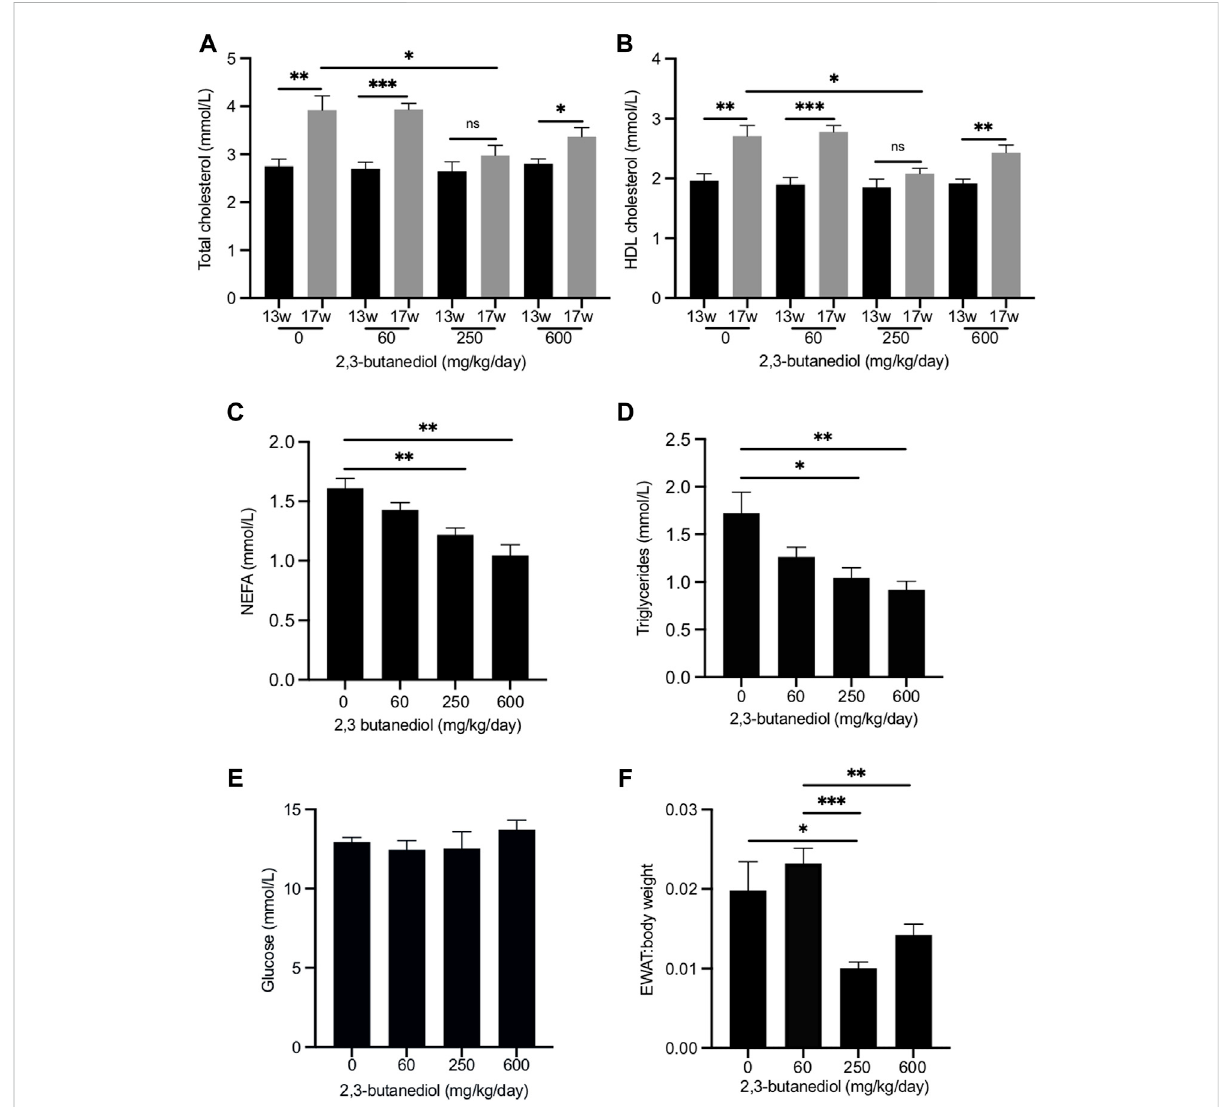
FIGURE 3 Dose-dependentin fl uenceof2,3-butanedioltreatmentonplasma metabolite concentrationsand fatdeposition. (A) Total cholesterol. (B) HDL cholesterol. (C) NEFA. (D) Triglycerides. (E) Glucose (F) EWAT:body weight ratio. Male mice were either untreated (0 mg/kg/day) or treated with 2,3- butanediol at either 60, 250 or 600 mg/kg/day, for 4 weeks from week 13 (13w) to week 17 (17w) of age. Cohorts, n = 4 or 5. Data are expressed as means ± SEM. * p < 0.05, ** p < 0.01, *** p <